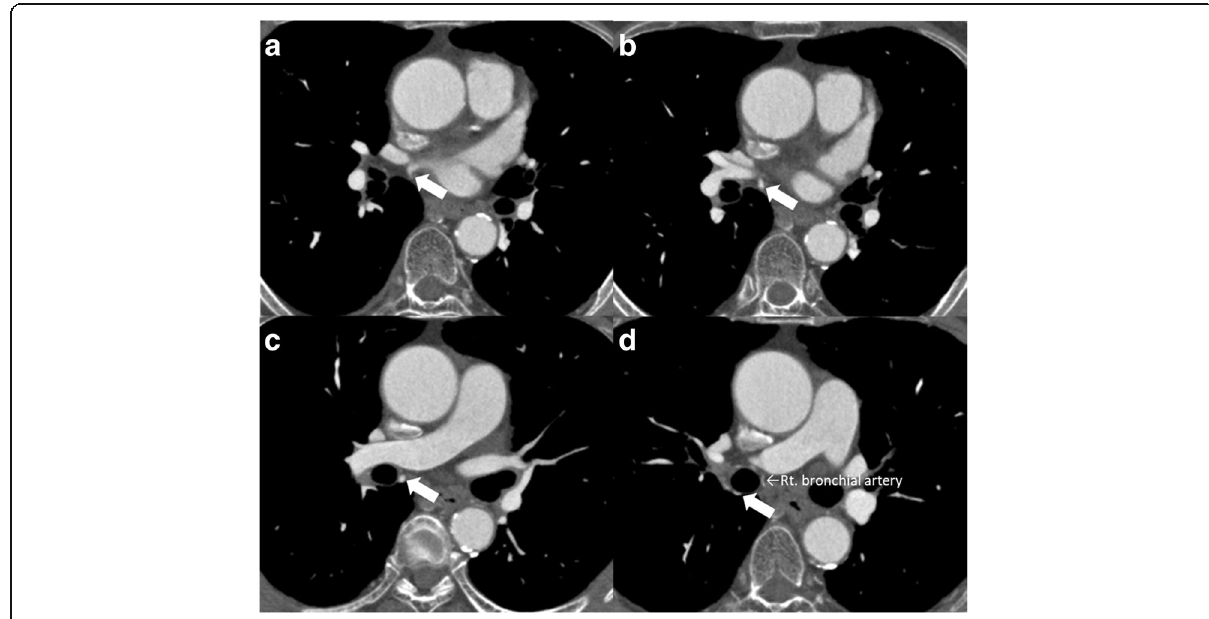
Fig. 2 CT image of the course of the anomalous V2. a Anomalous V2 draining into the RSPV. b – d Anomalous V2 running behind the intermediate bronchus